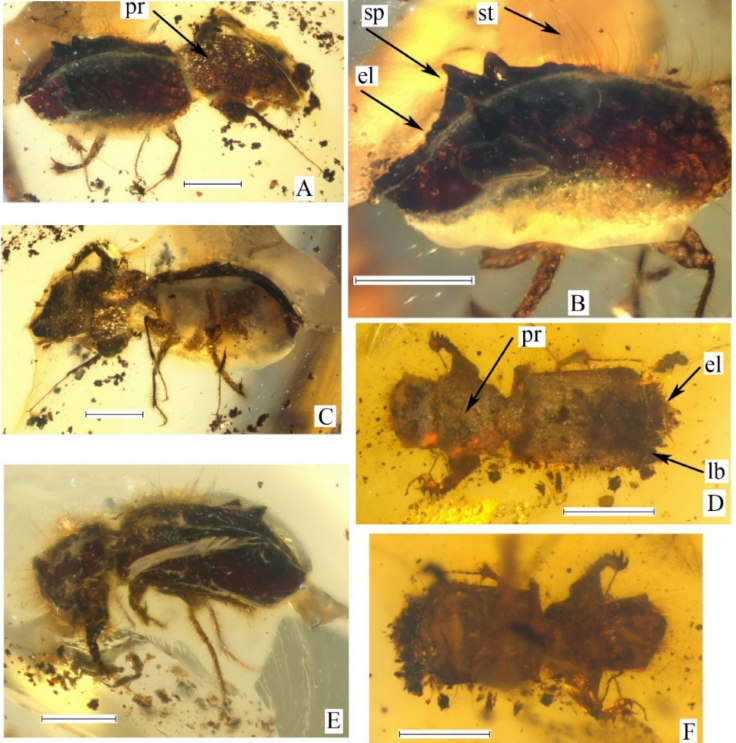
Figure 3. Poinarinius spp. in Myanmar amber: ( A ) P . borowskii sp. nov., holotype, female, ISEA MA2018/25, dorso-lateral view; ( B ) P . borowskii sp. nov., holotype, female, ISEA MA2018/25, elytra, dorsal view; ( C ) P . borowskii sp. nov., holotype, female, ISEA MA2018/25, ventral view; ( D ) P . lesnei sp. nov., holotype, female, ISEA MA2018/9, dorsal view; ( E ) P . borowskii sp. nov., paratype, female, ISEA MA2018/8, lateral view; ( F ) P . lesnei sp. nov., holotype, female, ISEA MA2018/9, ventral view. Scale bar 1.0 mm. Abbreviations: pr—pronotum, sp—spine, st—setae, lb—lobe, el—elytral